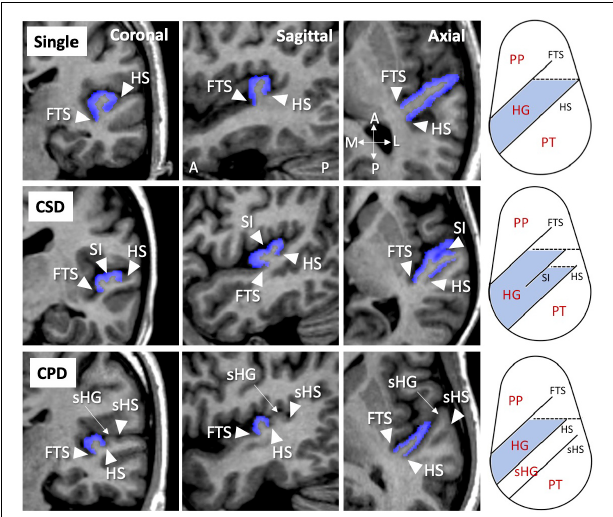
FIGURE 1 | Different Heschl’s gyrus gyrification patterns (colored in blue) in the left hemisphere on MR images in three directions and a schematic diagram on axial directions. A, anterior; CPD, complete posterior duplication; CSD, common stem duplication; FTS, first transverse sulcus; HG, Heschl’s gyrus; HS, Heschl’s sulcus; L, lateral; P, posterior; M, medial; PP, planum polare; PT, planum temporale; sHG, second Heschl’s gyrus; sHS, second Heschl’s sulcus; SI, sulcus intermedius. Note that these patterns were presented also in our previous publications